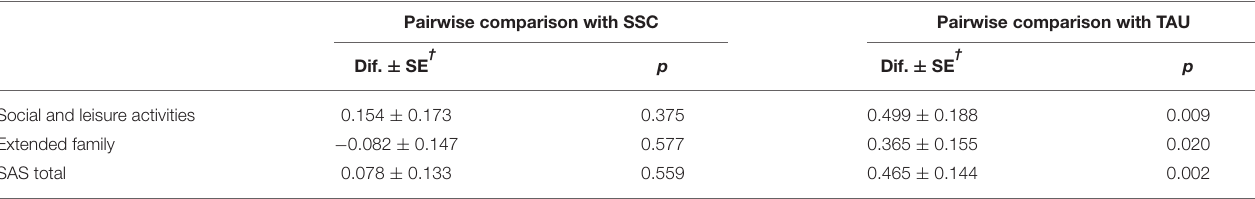
TABLE 3 | Secondary pairwise comparison analysis of IPSRT with SSC and TAU based on significant predictive values from GLM. Pairwise comparison with SSC Pairwise comparison with